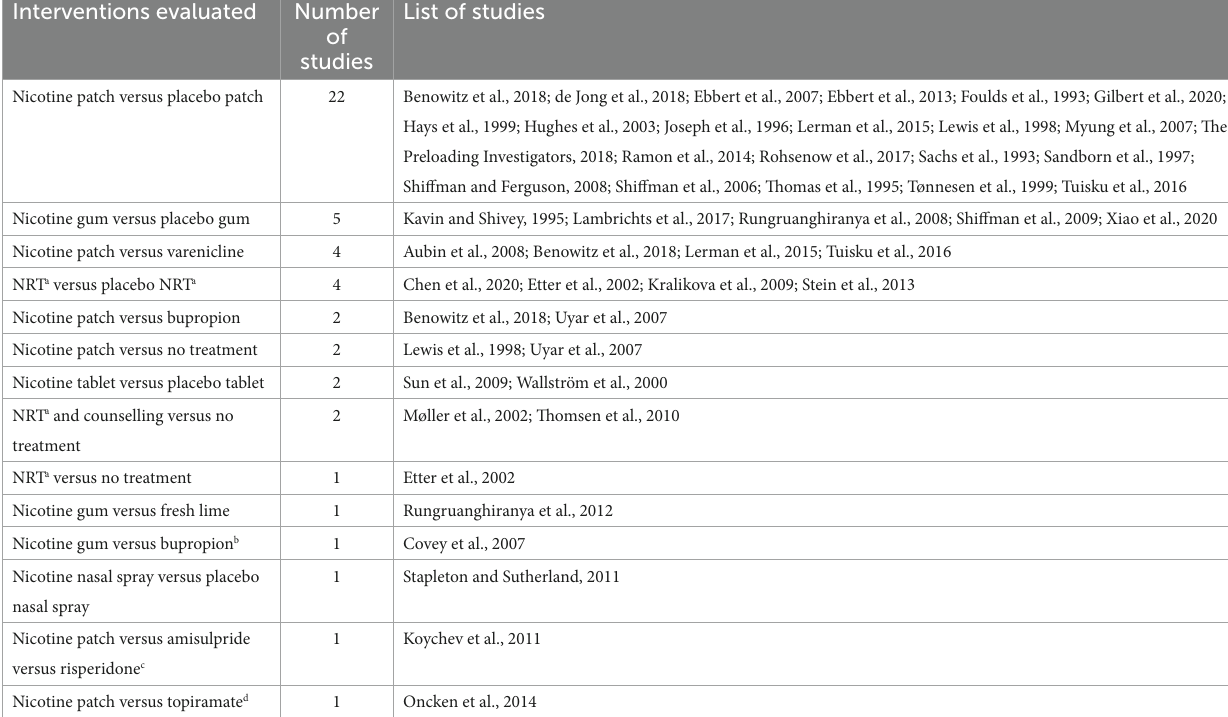
TABLE 4 Interventions evaluated among the included studies. Interventions